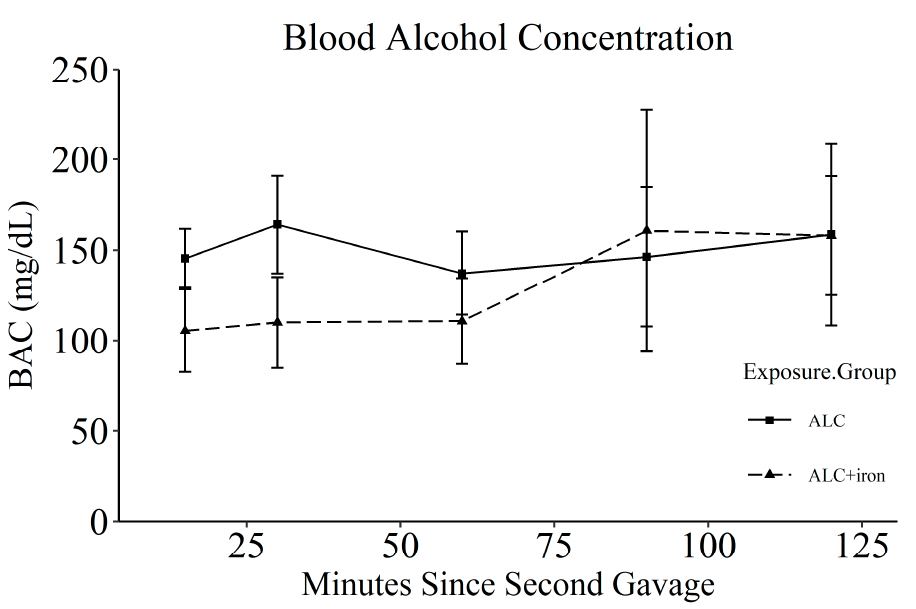
Figure 2. Blood alcohol concentrations of dams dosed with either alcohol ( n = 3) or alcohol and iron ( n = 3). Each data represents mean ± SEM. ALC, alcohol exposed; BAC, blood alcohol